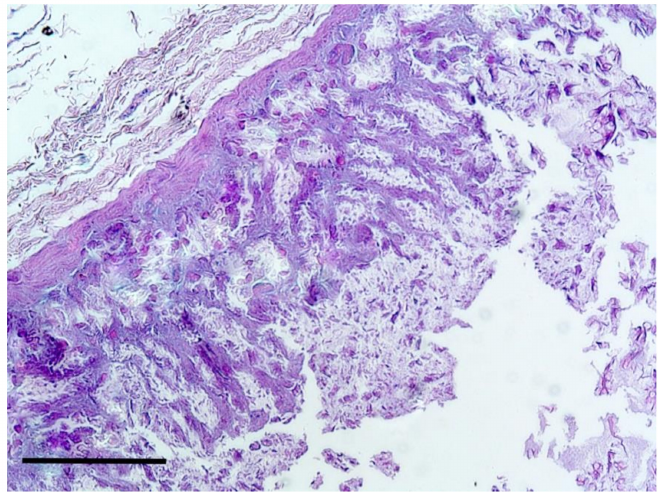
Figure 7. Stomach. Exfoliation of the mucosa with presence of catarrhal exudate mixed with inflammatory cells. H&E staining, bar = 100 µ m.